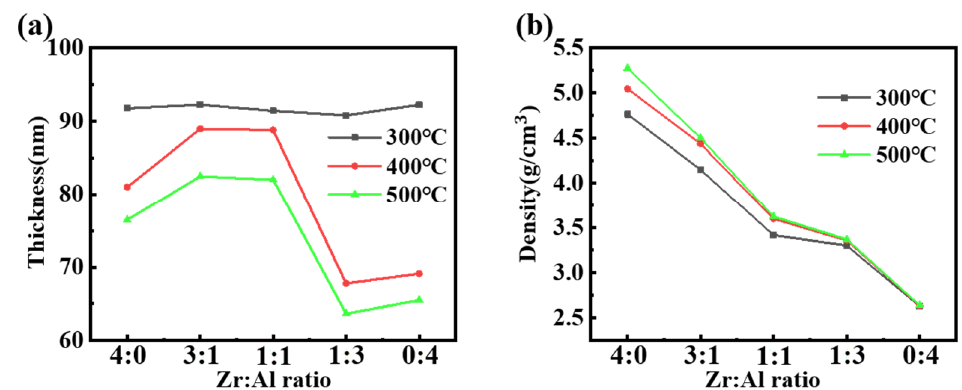
Figure 2. ( a ) The relationship among the thin film thickness, mixing ratio and annealing temperature and ( b ) the relationship among the thin film density, mixing ratio and annealing temperature.